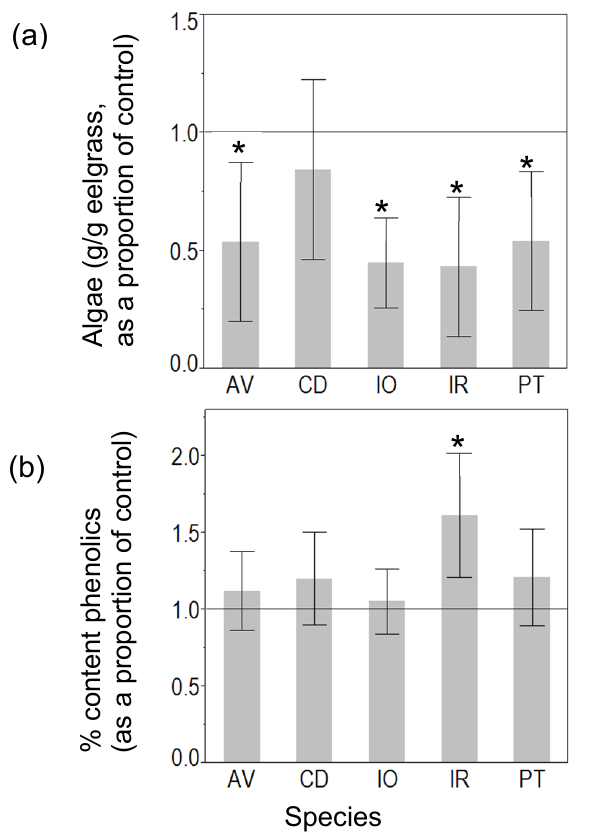
Figure 2. Effects of grazer species on ( a ) epiphytic algae mass per mass of eelgrass and ( b ) eelgrass phenolic content, as a proportion of the control, at the end of Phase 1 of